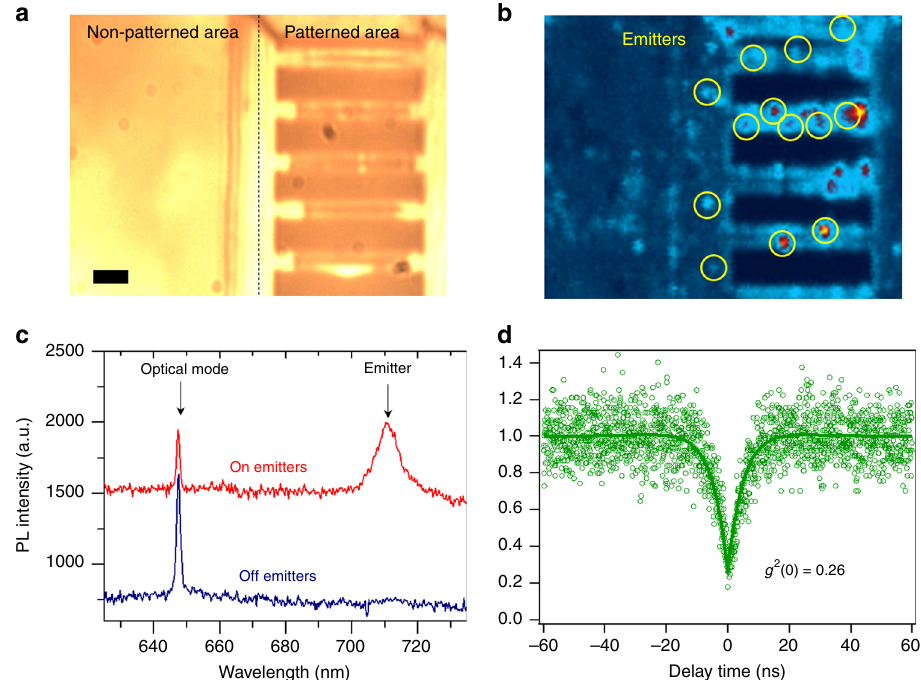
Fig. 4 Generation of single photon emitters within the hBN cavities. a optical microscope image of the analyzed area comparing an unprocessed site (left), with a processed site (right) that contains several 1D nanobeam cavities. The scale bar corresponds to 1 µ m. b corresponding Photoluminescence map of this region. Positions of quantum emitters are indicated by yellow circles c PL spectra from two regions of the same cavity showing an optical mode only (blue) and the combination of an optical mode and an emitter (red). d Measured g 2 ( τ ) curve obtained from this